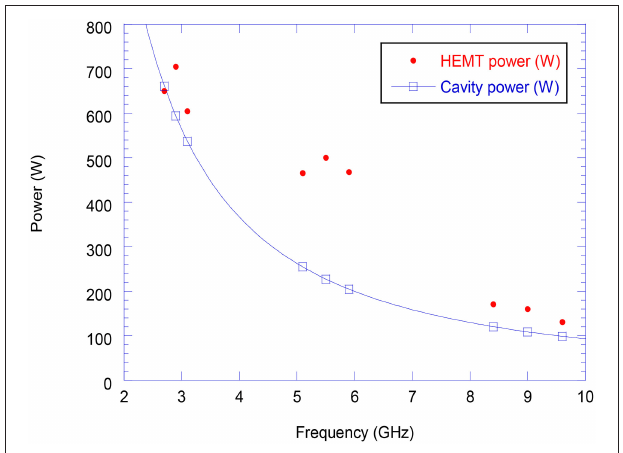
FIGURE 5 | Plot of HEMT output power (red) and calculated cavity power (blue) vs. frequency.